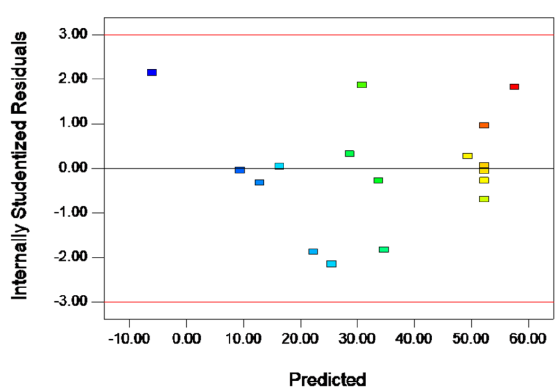
Figure 6. Residuals vs. predicted values.